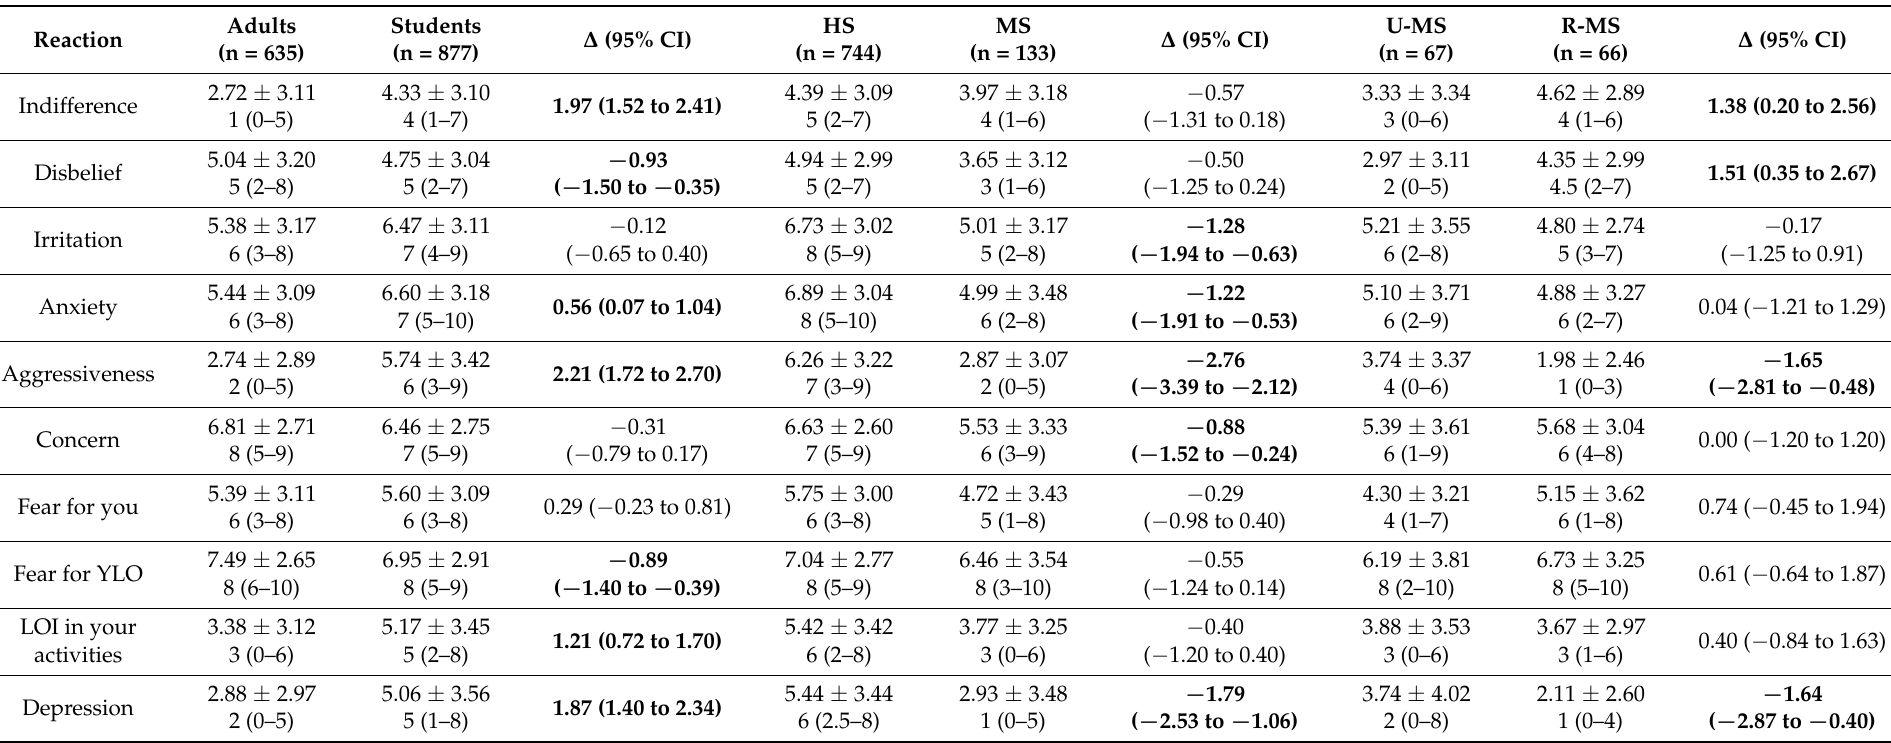
Table 2. Baseline characteristics of the whole sample by subgroups: data for each group are reported as mean ± SD, median and range (in brackets); data in bold indicate the most significant difference between adults and students in terms of their emotional